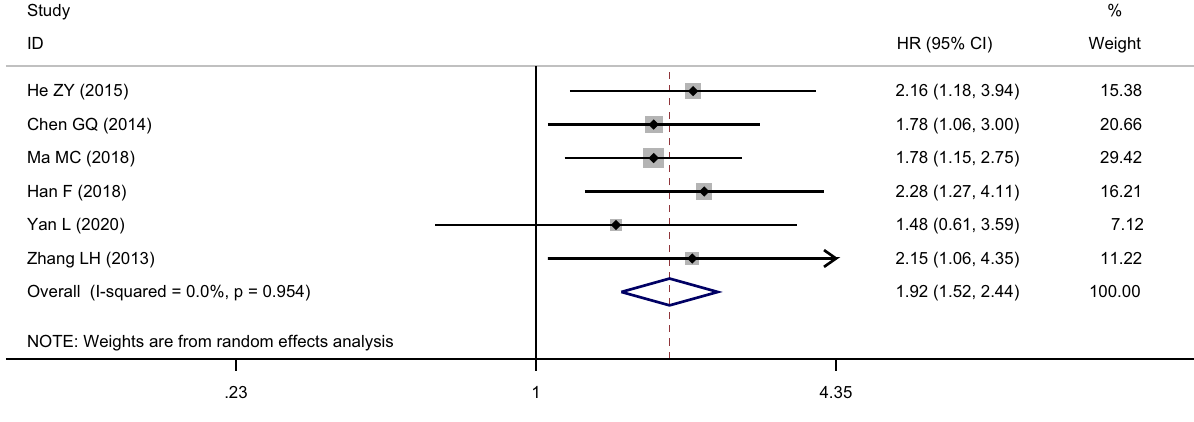
Figure 7: Relationship between SIRT1 and overall survival of